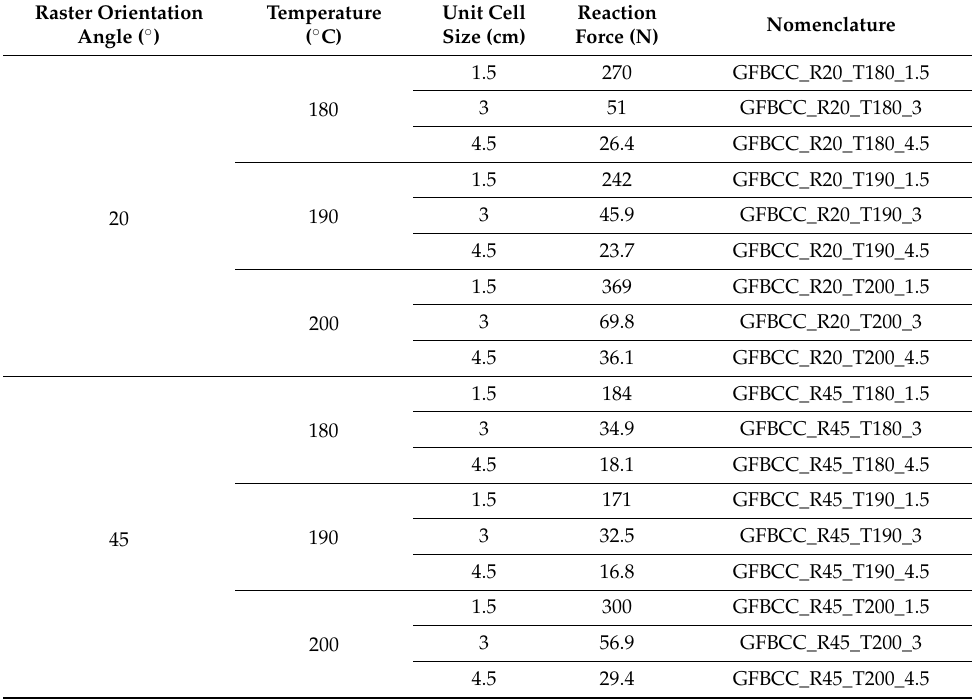
Table A4. Results obtained for tipo